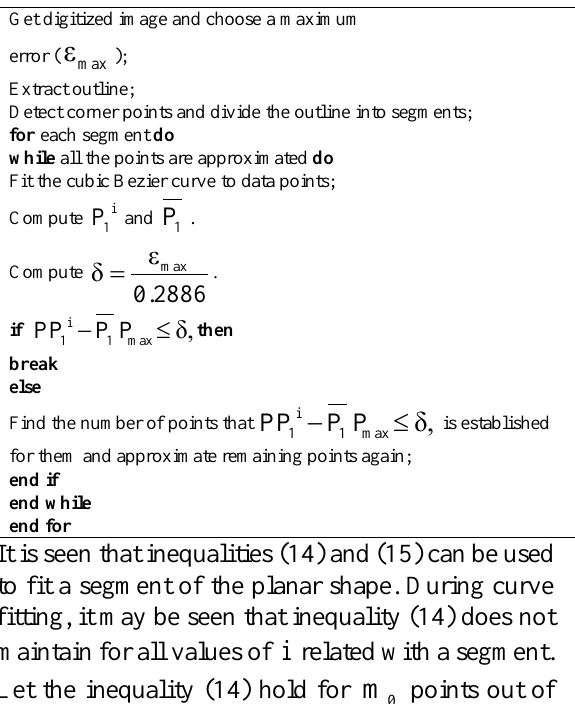
Algorithm 1. The outline capturing system.